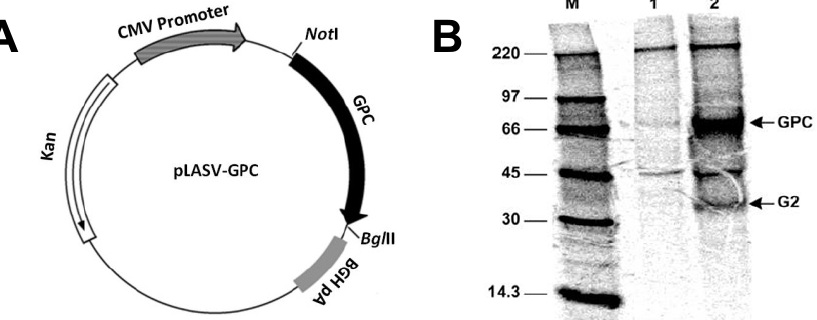
Figure 1. Plasmid Map and Immunoprecipitation and polyacrylamide gel electrophoresis (PAGE) of radiolabeled LASV strain Josiah glycoprotein precursor (GPC, 76 KD). ( A ) Map of pLASV-GPC cloned into the pWRG7077 vaccine plasmid. ( B ) Radioimmunoprecipitation and PAGE of LASV GPC and GP2 from COS-7 cell lysate. Expression products from COS-7 cells transfected with (Lane 1) empty vaccine plasmid pWRG7077 or (Lane 2) recombinant pLASV-GPC, and immunoprecipitated with LASV-immune guinea pig serum. The sizes of molecular weight markers M and the location of bands